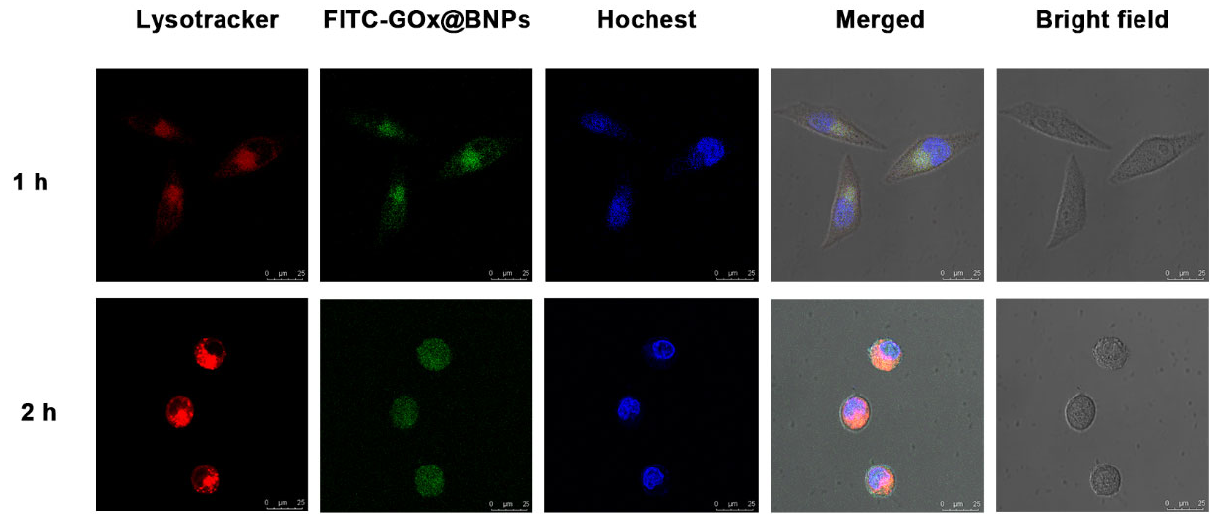
Figure 6. Confocal fluorescence imaging of FITC ‐ GOx@BNPs (10 μ M) in A549 cells at 37 °C for 1 h and 2 h. Scale bars: 25 μ m.